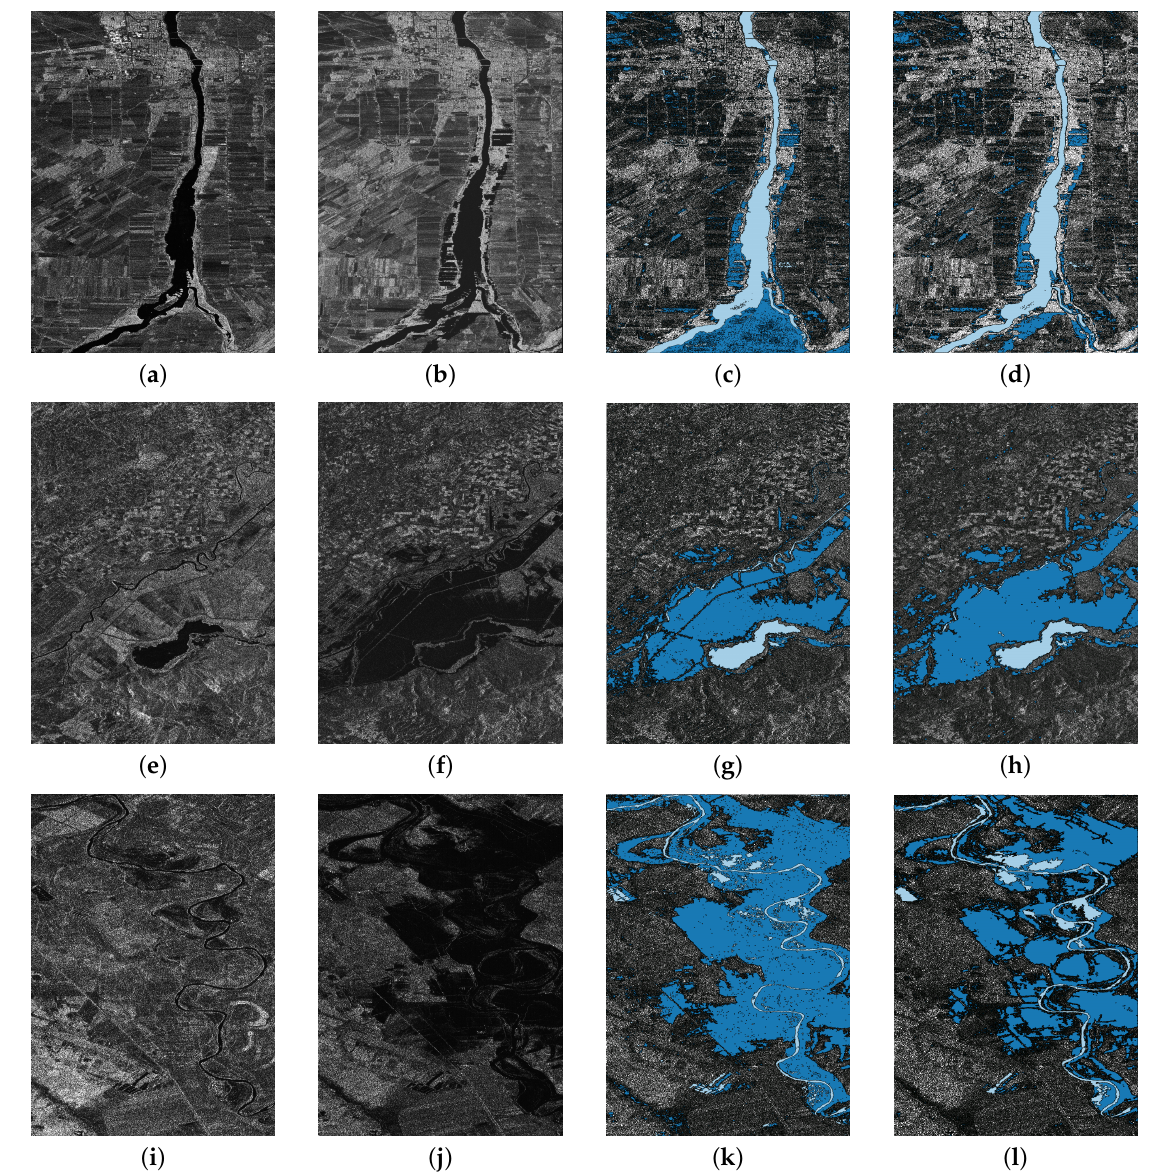
Figure 11. Results of Clement et al. [53] and D’Addabbo et al. [54] methods application. ( a ) Pre-disaster image (site 1); ( b ) Post-disaster image (site 1); ( c ) Results obtained using Clement et al. [53]; ( d ) Results obtained using D’Addabbo et al. [54]; ( e ) Pre-disaster image (site 2); ( f ) Post-disaster image (site 2); ( g ) Results obtained using Clement et al. [53]; ( h ) Results obtained using D’Addabbo et al. [54]; ( i ) Pre-disaster image (site 3); ( j ) Post-disaster image (site 3); ( k ) Results obtained using Clement et al. [53]; ( l ) Results obtained using D’Addabbo et al. [54].